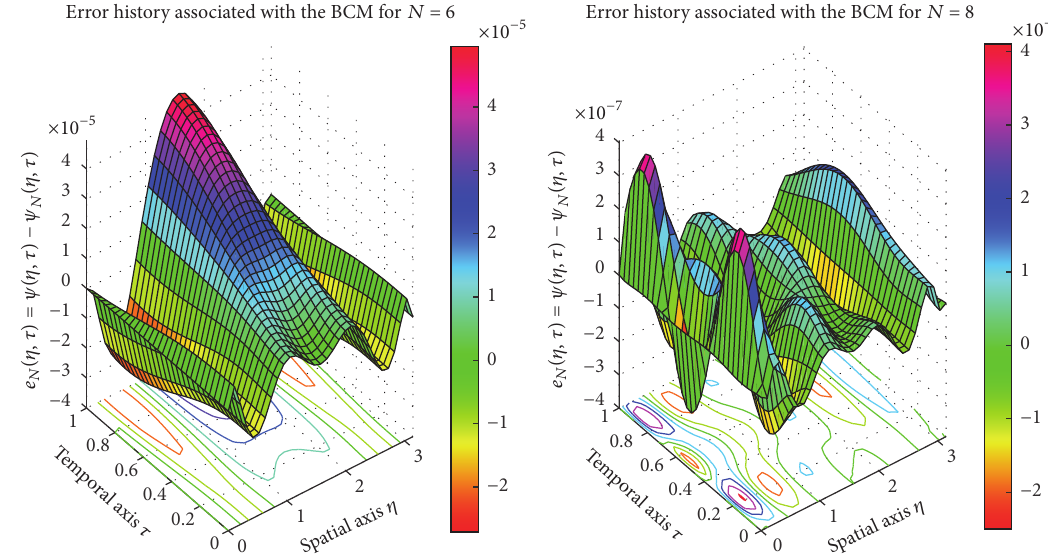
Figure 7: Error histories associated with the obtained numerical solution of the second example for 𝑁 = 6, 8 .